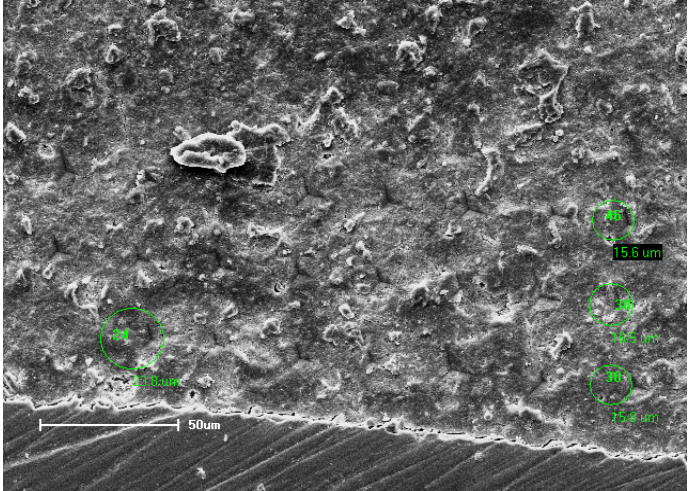
Figure 5. Micrograph (400X) of indentation matrix 2 located at the steel microfiber-paste interface showing all 24 indentation points ~30 µm from each other, distributed in 8 columns and 3 rows (4 points highlighted).